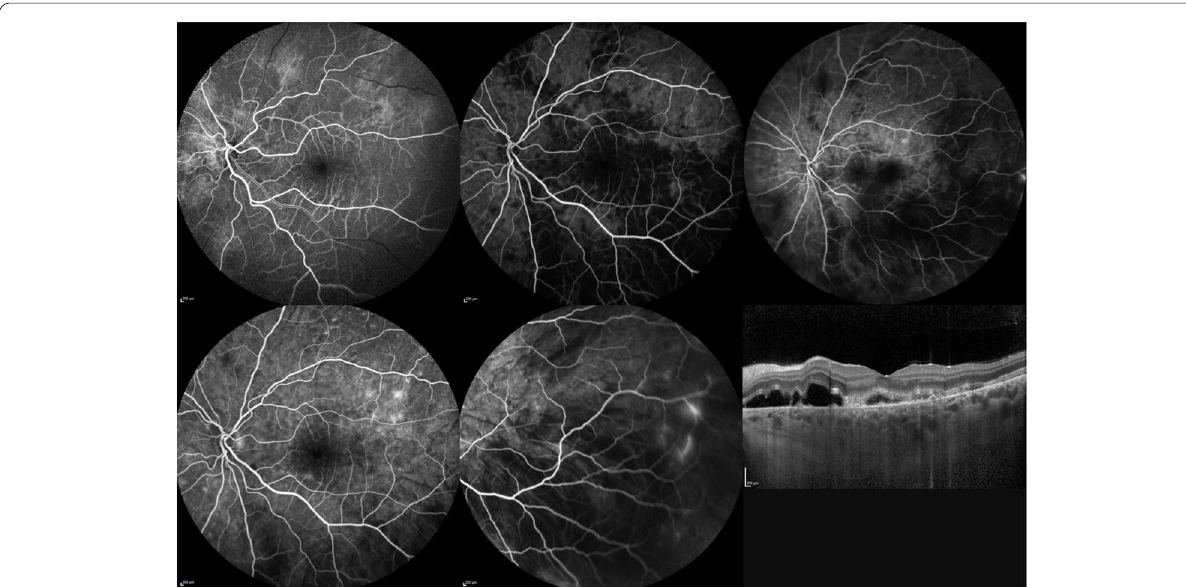
Fig. 4 Fluorescein angiography and optical coherence tomography imaging of the left eye of a 20 year‑old woman with Takayasu arteritis. Fluorescein angiography shows delayed patchy filling of the chororoid at 14 s ( top left ), 40 s ( top middle ), and 3 min ( top right ), pinpoint leaks at the level of retinal pigment epithelium seen at 3 min ( top right ) becoming more evident at 6 min ( bottom left ). Temporal peripheral frame at 6 min shows choroidal nonperfusion and focal leak of peripheral retinal vessels ( bottom middle ). SD‑OCT scan of the macula shows serous retinal detachment ( bottom right )